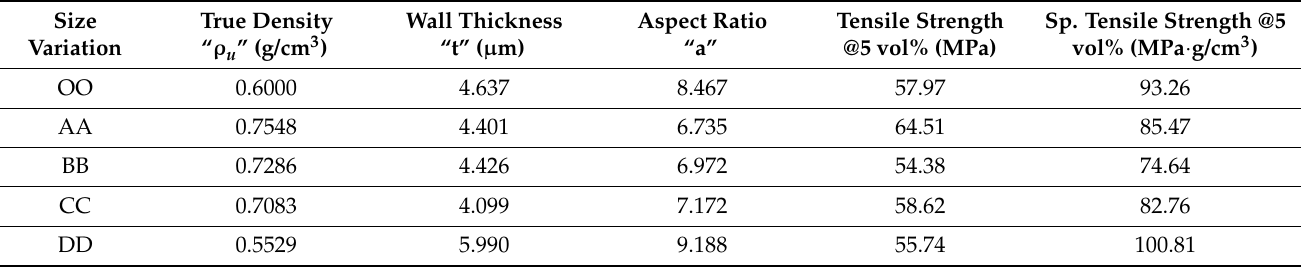
Table 2. Characteristics properties of syntactic foam composites with varied particle sizes and true